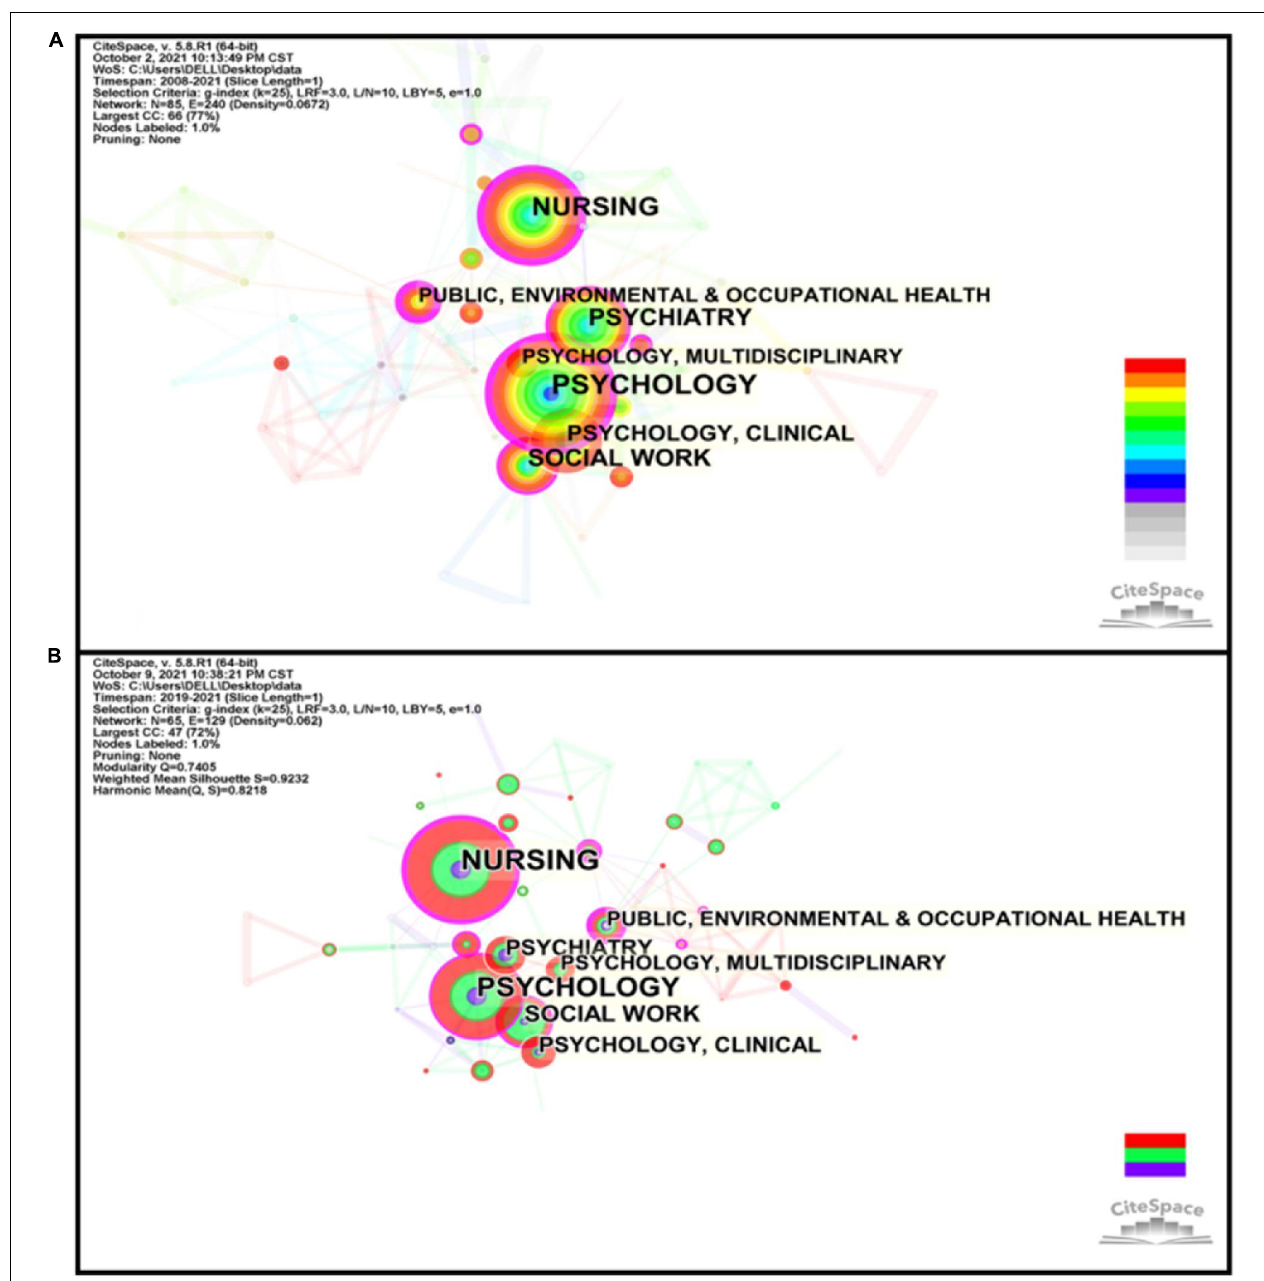
FIGURE 2 | The co-occurrence network of subject categories in the field of compassion fatigue (CF) and psychological resilience (PR) during 2008–2021 (A) and the COVID-19 pandemic (B) . A circle indicates a subject category. The various colors of nodes indicate the different years, and the size of a circle was weighted by the amount of literature on the category. The link between two nodes represents the interdisciplinary interaction of the literature, and the thickness of the lines was weighted by the relevance between different areas of research. The purple rims of circles indicate high betweenness centralities.